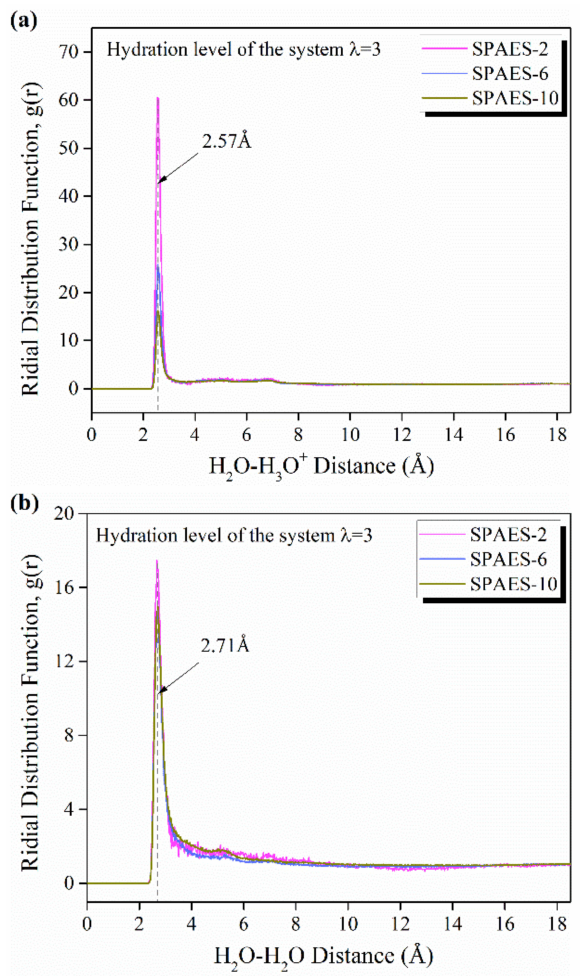
Figure 7. RDFs of water molecules and ( a ) hydronium ions as well as ( b ) water molecules for the membrane with various side chain length of 2, 6 and 10, respectively, at hydration level of λ =